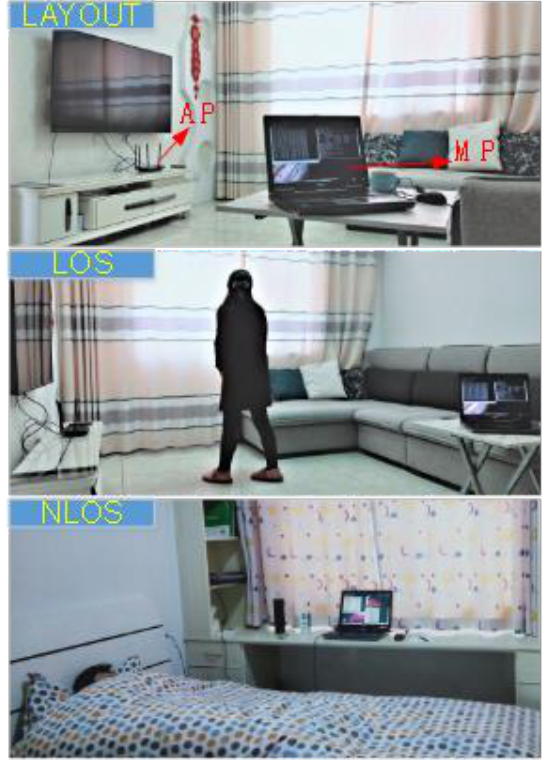
Figure 16. The interest area for extracting features.